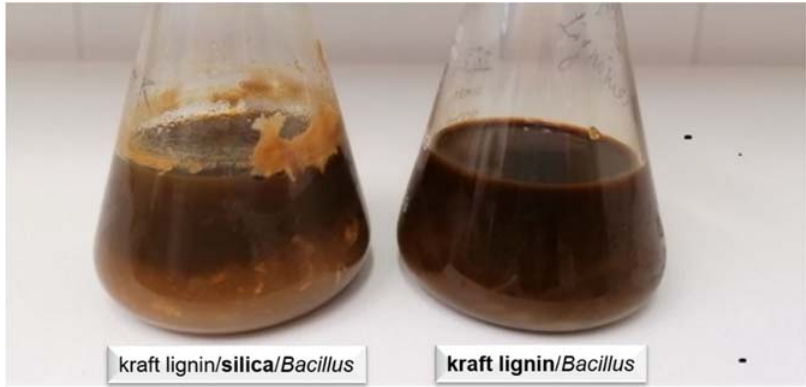
Figure 8. A Bacillus amyloliquefaciens cell culture with the carriers added.